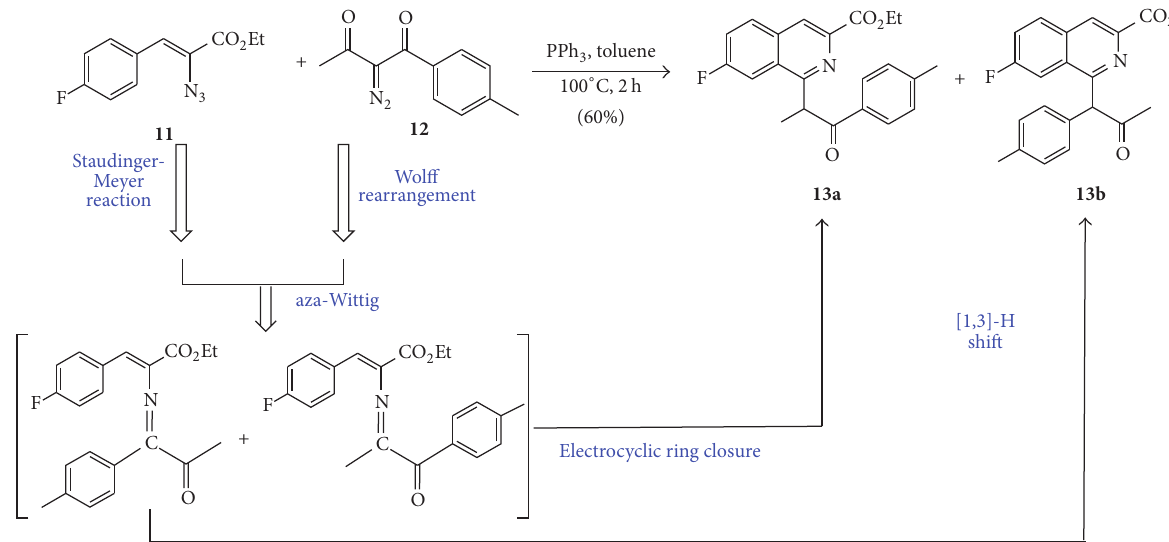
Scheme 4: Triphenylphosphine-mediated 7-fluoroisoquinoline synthesis.